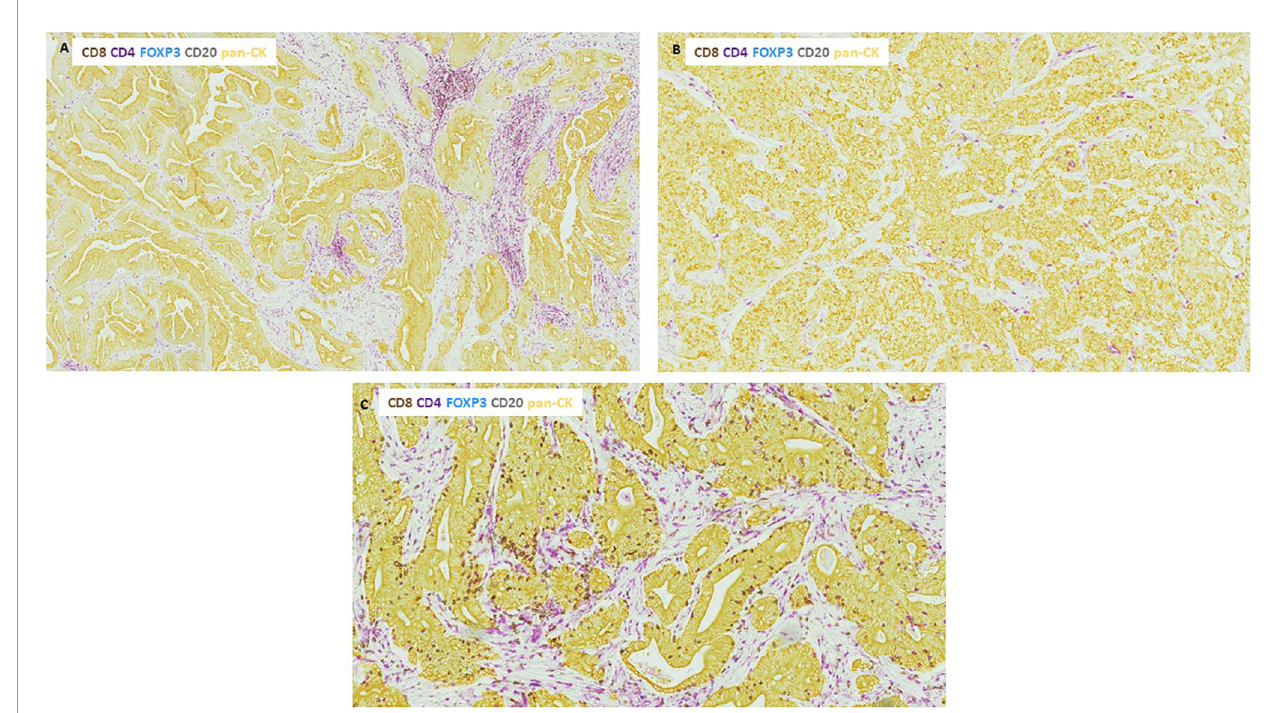
FIGURE 3 | Representative images showing differential immune in fi ltration in colon cancer tissue. (A) Tumor exhibiting patchy immune in fi ltration consisting of areas with heavy in fi ltration combined with sparsely in fi ltrated areas. (B) Dense tumor tissue with sparse stroma and modest immune in fi ltration. (C) Highly immune in fi ltrated tumor with abundant immune cells located within both the tumor tissue and stromal spaces. All images are of the adaptive panel (CD8+ T cells, CD4+ T cells, CD4+foxp3 T cells, CD20+ B cells) of IHC-stained immune